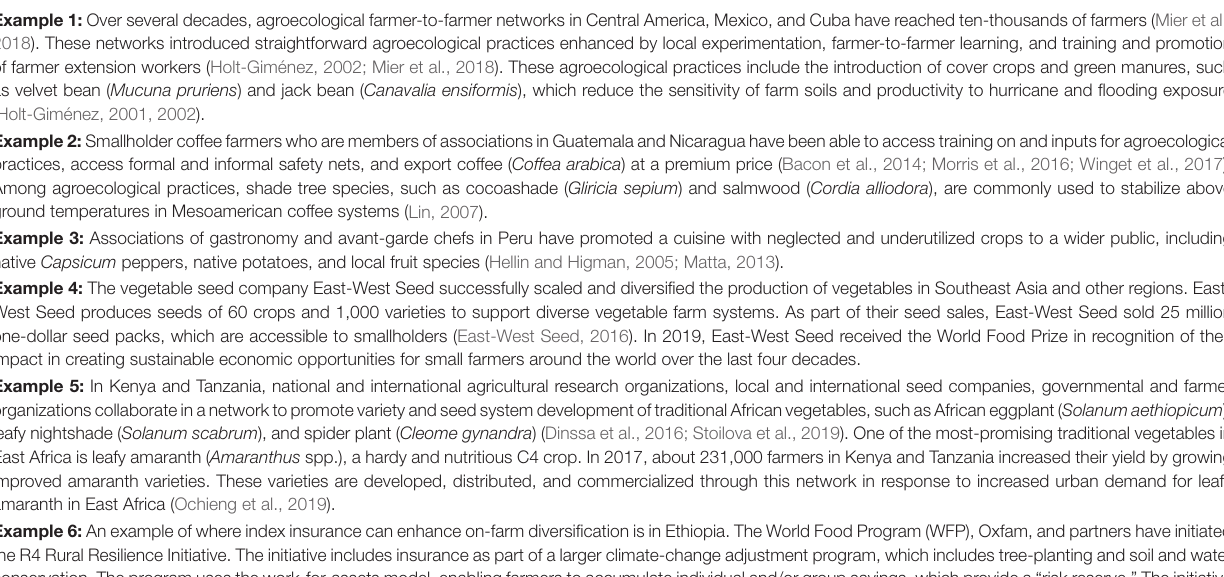
TABLE 1 | Examples of successful societal, public and private initiatives to support farmers in diversifying their farm systems. Example 1: Over several decades, agroecological farmer-to-farmer networks in Central America, Mexico, and Cuba have reached ten-thousands of farmers (Mier et al., 2018). These networks introduced straightforward agroecological practices enhanced by local experimentation, farmer-to-farmer learning, and training and promotion of farmer extension workers (Holt-Giménez, 2002; Mier et al., 2018). These agroecological practices include the introduction of cover crops and green manures, such as velvet bean ( Mucuna pruriens ) and jack bean ( Canavalia ensiformis ), which reduce the sensitivity of farm soils and productivity to hurricane and flooding exposure (Holt-Giménez, 2001,